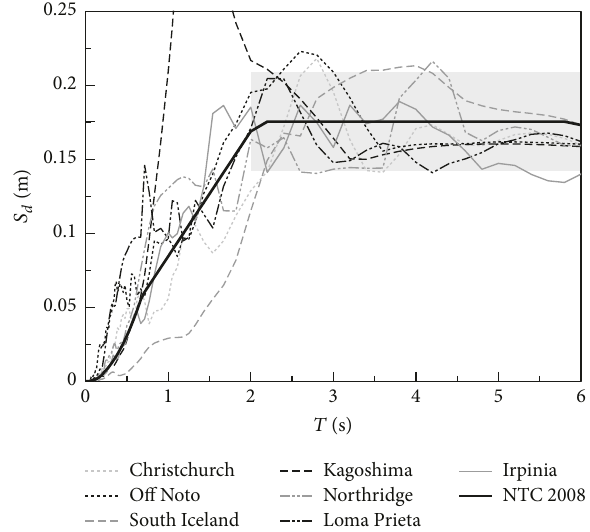
Figure 12: Ground motion displacement response spectra compar- ing with the Italian Code (NTC2008) elastic response